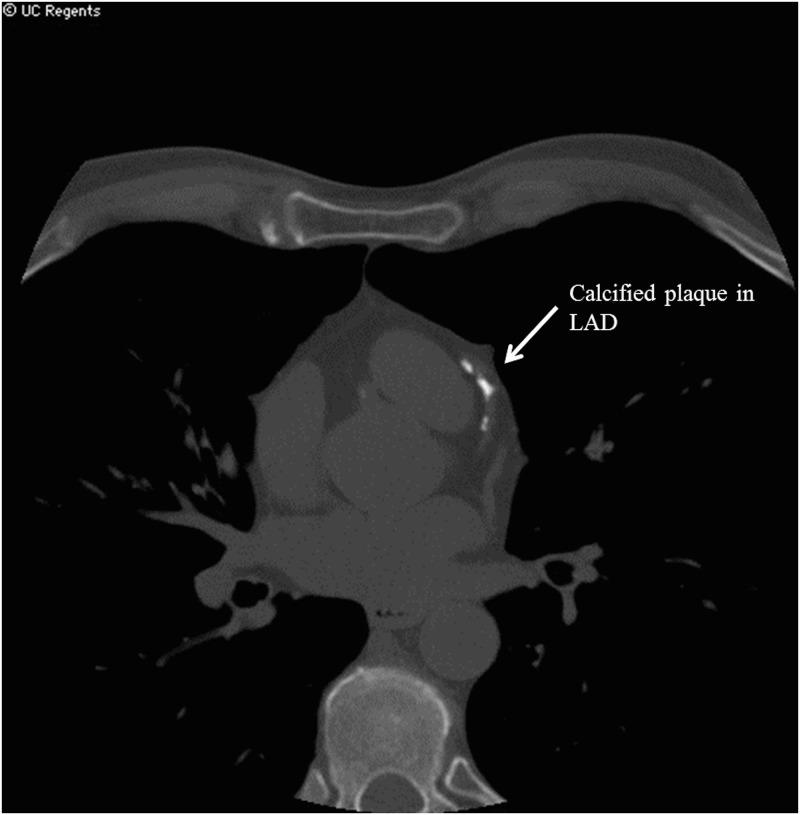
CAC EBCT of a subject with detectable CAC.Abbreviations: Coronary artery calcium (CAC), External beam computed tomography (EBCT).